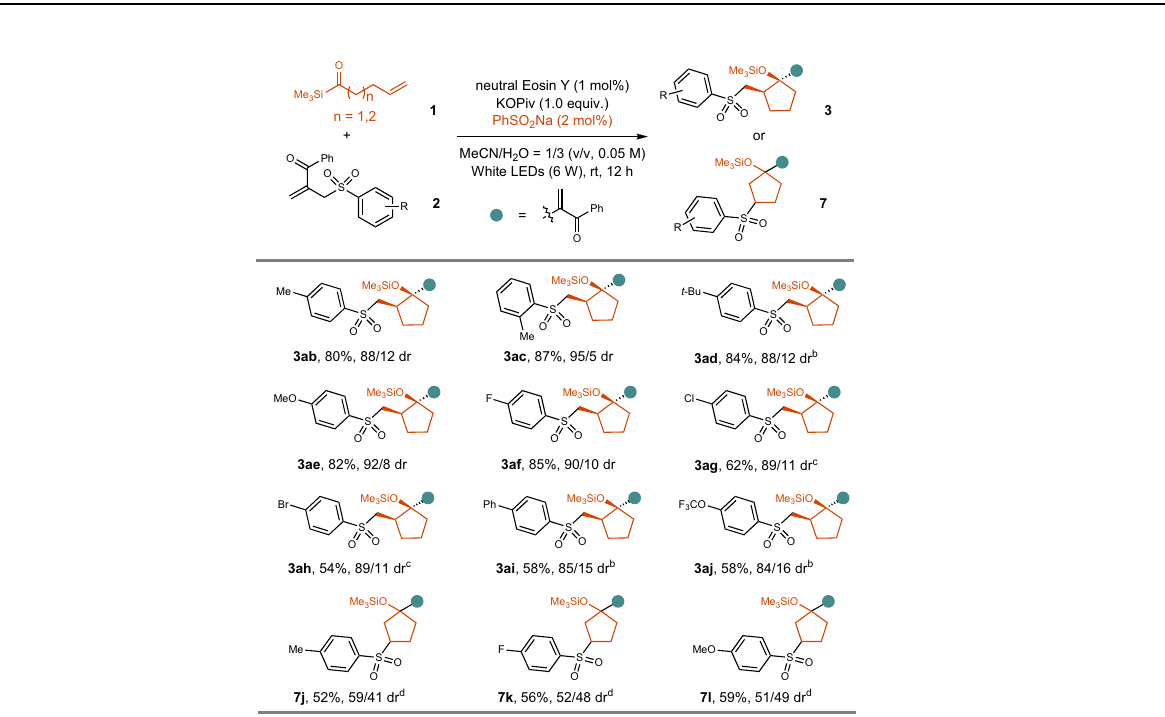
Fig. 4 | Scope for the synthesis of γ -substituted cyclopentanol derivatives. a Total yield of the isolated two diastereoisomers is reported. b Yield of the alcohol after desilylation with TBAF is reported. c neutral Eosin Y (2mol%), KOPiv (1.5 equiv.), 36h.